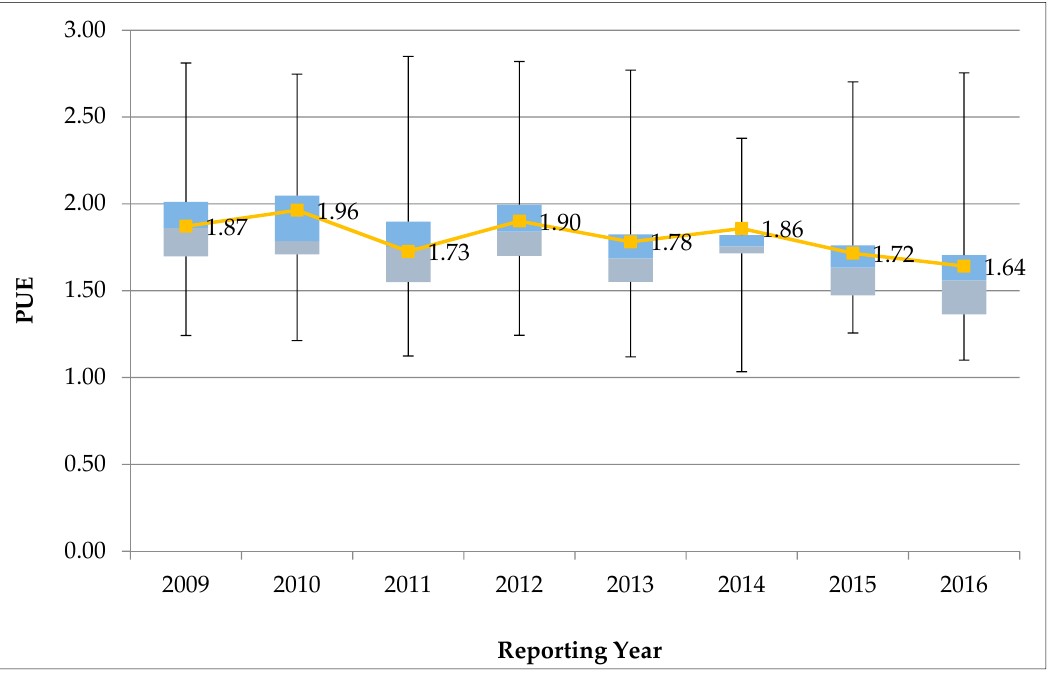
Figure 3. Average PUE per reporting year.